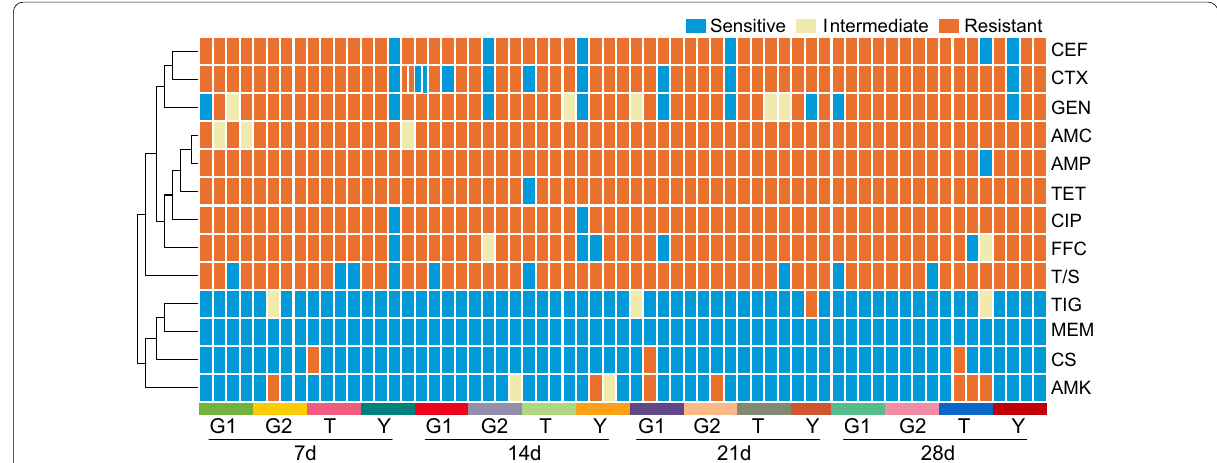
Fig. 2 AMR profiles of 63 E. coli strains. AMP ampicillin, AMC amoxicillin/clavulanate potassium, CTX cefotaxime, CEF ceftiofur, AMK amikacin, GEN gentamicin, TET tetracycline, TIG tigecycline, MEM meropenem, CS colistin, CIP ciprofloxacin, T/S sulfamethoxazole, FFC florfenicol